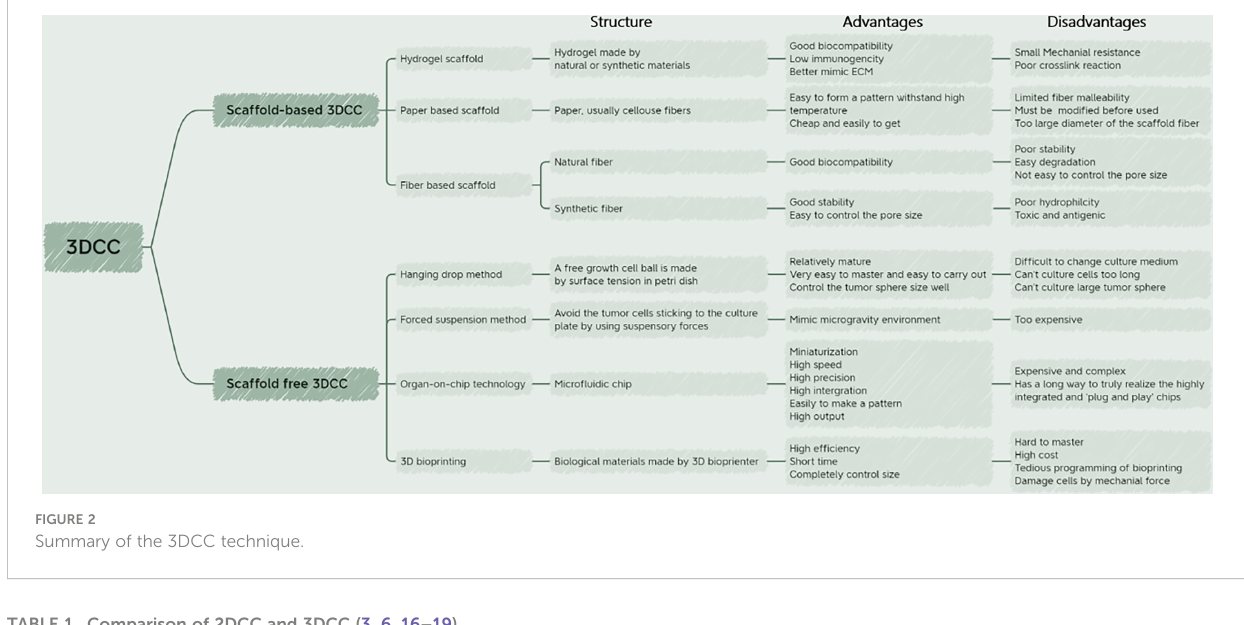
TABLE 1 Comparison of 2DCC and 3DCC (3, 6, 16 –